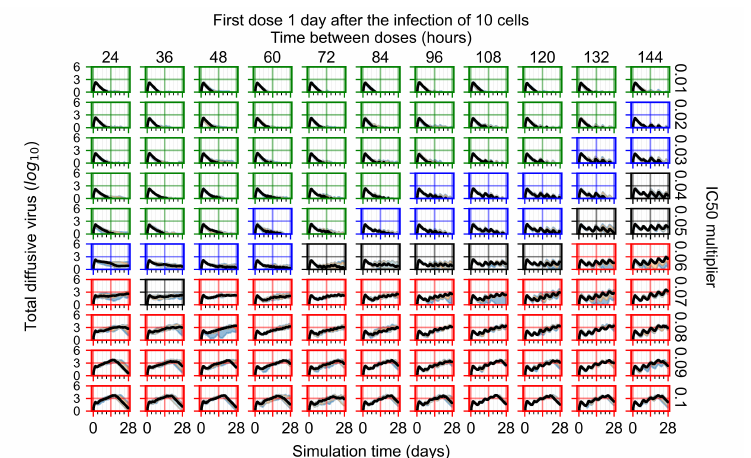
Figure A25. Extracellular diffusive virus quantities (arbitrary units), Y axis in log scale, and exponent values as tick